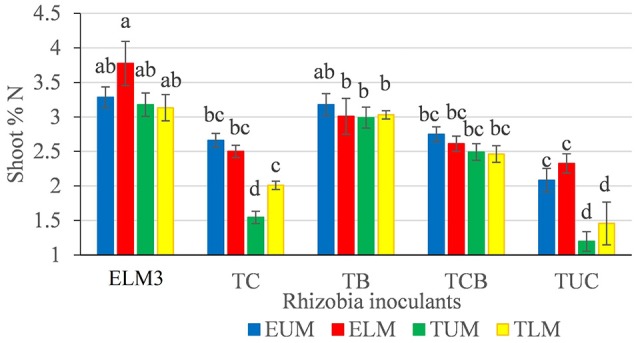
Interactive effects of farm location with rhizobia inoculants on % shoot N of climbing beans. Bars followed by the same letter are not significantly different according to Tukey's HSD test at P ≤ 0.05. ELM3, Test native rhizobia isolate; TC, Consortium of native rhizobia; TB, Commercial inoculant (Biofix); TCB, Biofix combined with consortium; TUC, Negative control (Non-inoculated); ELM, Embu Lower Midland; EUM, Embu Upper Midland; TLM, Tharaka Nithi Lower Midland; TUM, Tharaka Nithi Upper Midland.